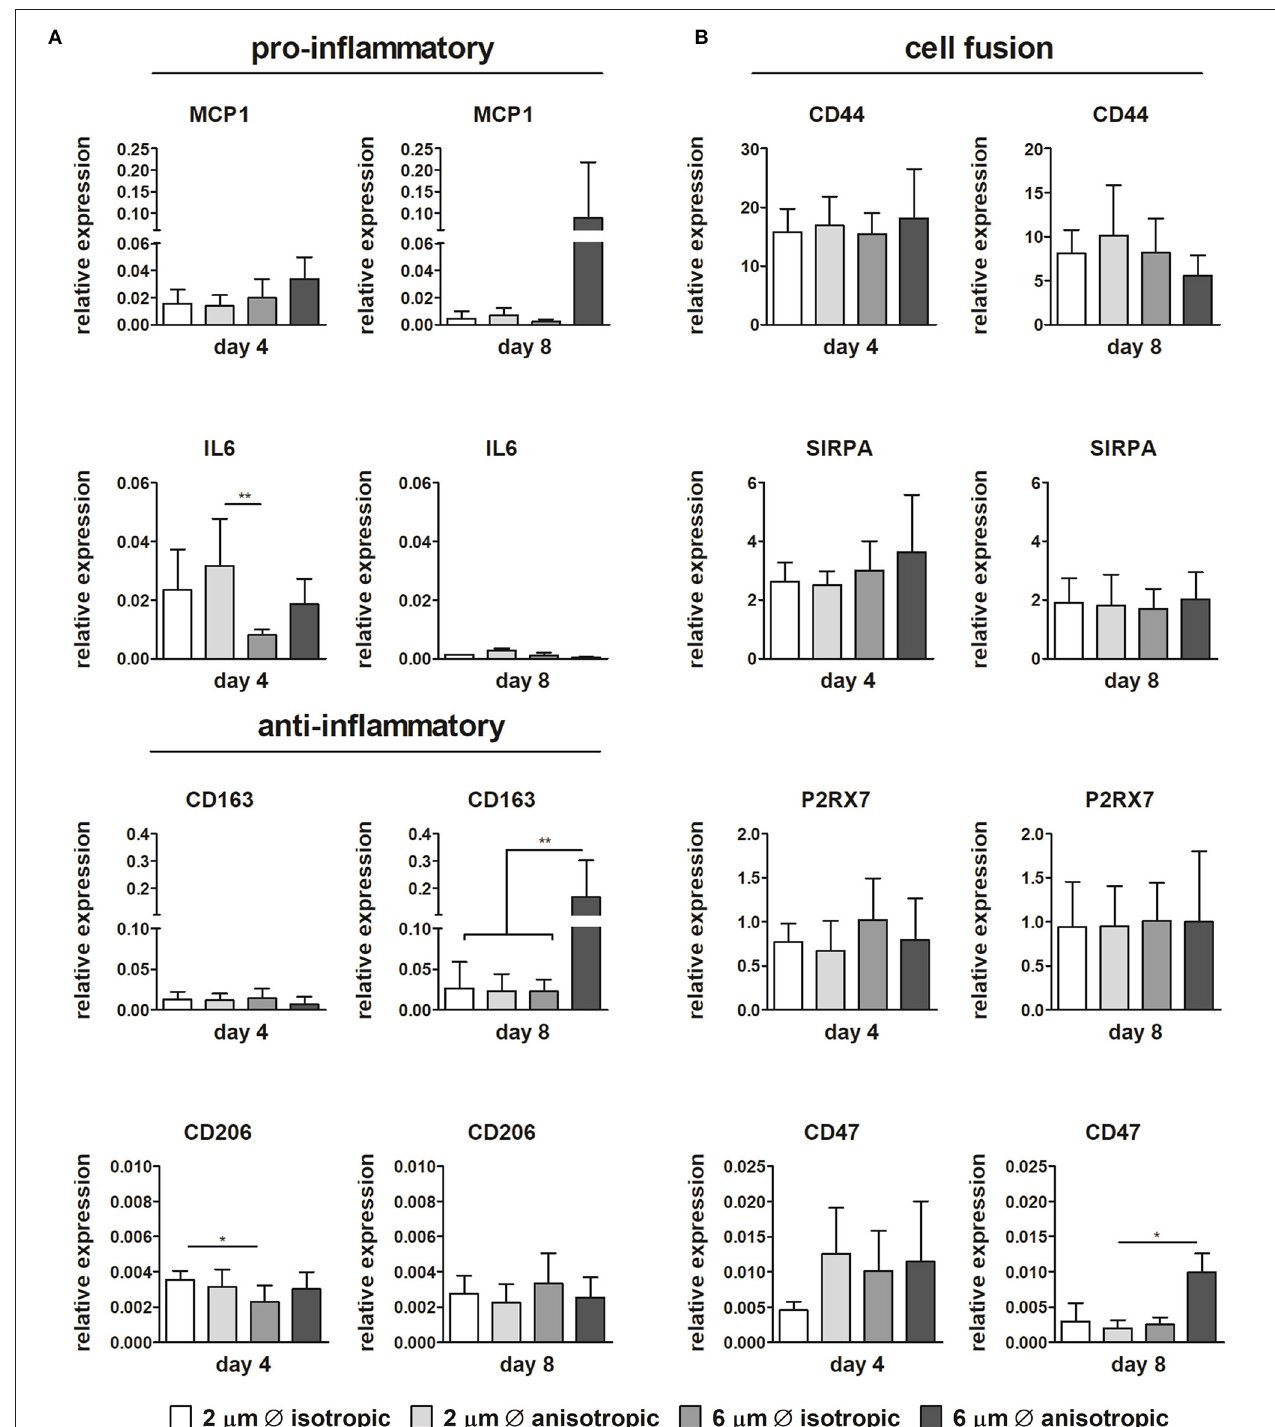
FIGURE 5 | Gene expression profiles. Relative expression of pro- and anti-inflammatory genes in macrophages cultured up to day 4 and day 8 on scaffolds with different microarchitectures (A) . Relative gene expression of cell fusion markers CD44, SIRPA, the P2x7 receptor, and CD47 (B) . CYC-1 was selected as the reference gene. * p < 0.05; ** p < 0.01. N ≥ 3/group/time point.